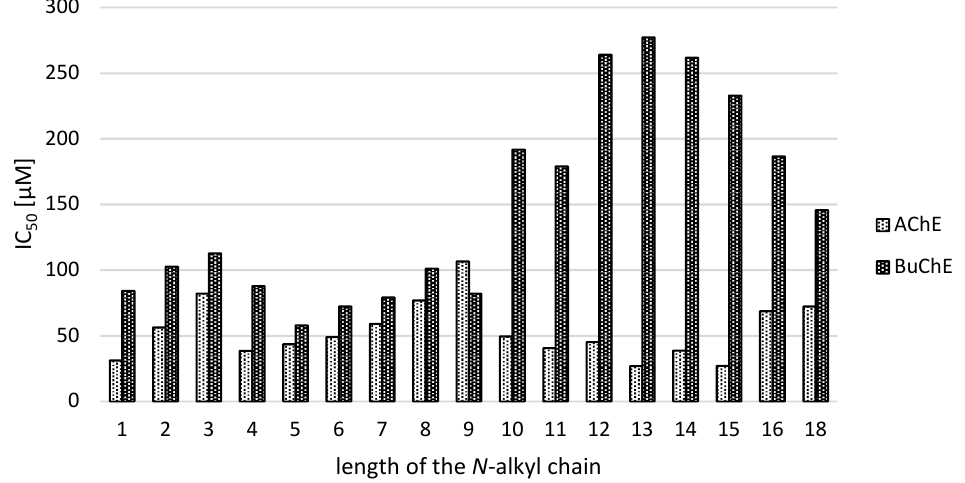
Figure 1. The dependence of enzyme inhibition on alkyl chain length of N -substituted-2-[4- (trifluoromethyl)benzoyl]hydrazine-1-carboxamide scaffold 2 .